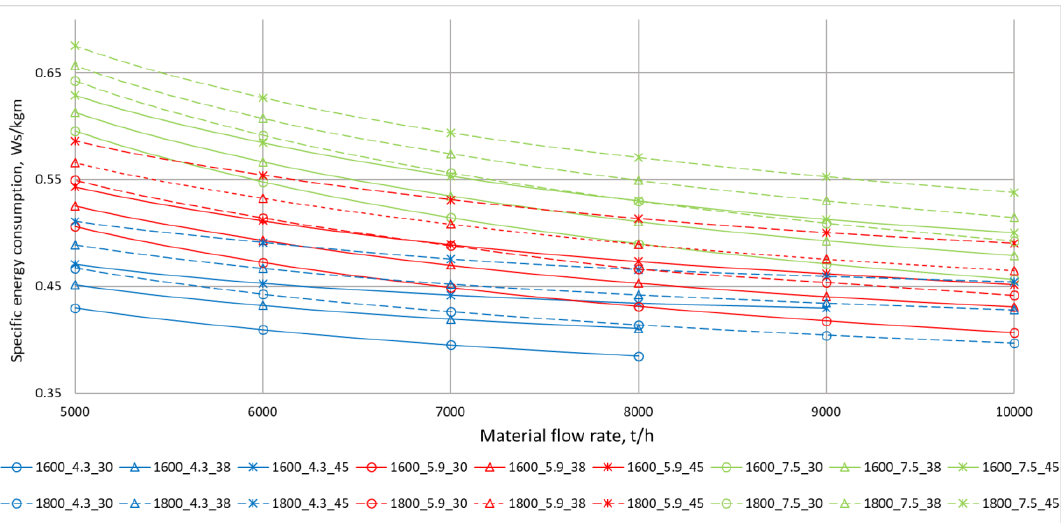
Figure 4. Relationship between specific energy consumption of the conveyor and material flow rate above 5000 t/h for different conveyor design parameters. (Code in the legend represents the belt width, speed, and troughing angle).